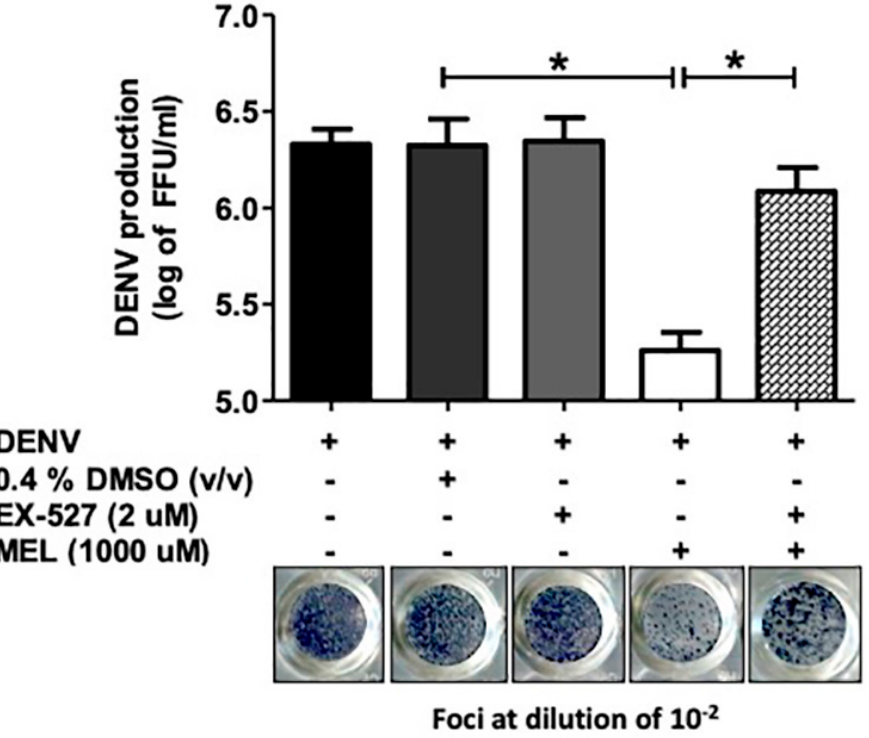
Figure 6. Effect of sirtuin 1 (SIRT1) inhibition with and without MEL treatment in DENV2-infected Huh7 cells. Huh7 cells were infected with DENV2 at MOI 1 and treated with the vehicle control or MEL with and without EX-527. Supernatants were collected at 24 h pi for virus titration. The asterisk (*) sign denotes p < 0.05 considered to be statistically significant.